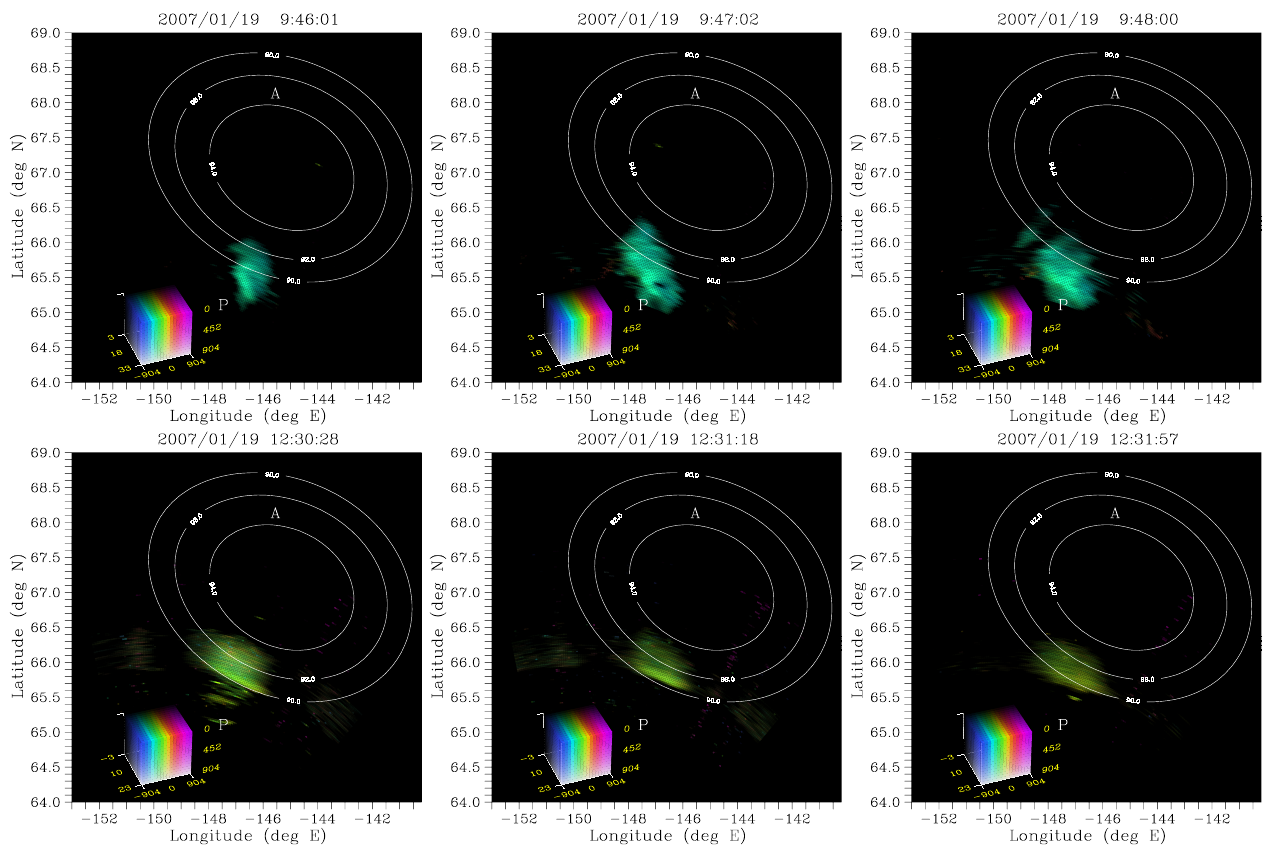
Fig. 3. Radar images from 19 January 2007. The brightness, hue, and saturation of the image pixels represent signal-to-noise ratio, Doppler shift, and spectral width on the legend shown. The integration times for the images is about 3.5s. The “P” and “A” symbols give the locations of the Poker Flat range and Arctic Village, respectively. Contours show the altitudes where the condition for field-aligned backscatter is satisfied from Anchorage in the absence of refraction (see